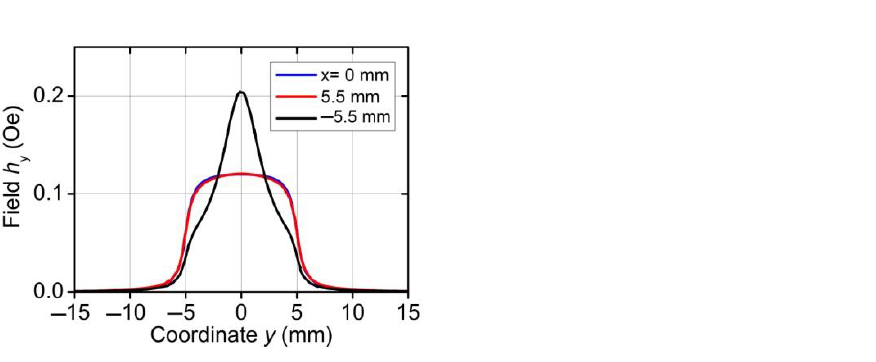
Figure 5. Distribution of the magnetic field h y along the width inside the "magnetic capacitor" for I = 100 mA and z = 0. I = 100 mA and z =